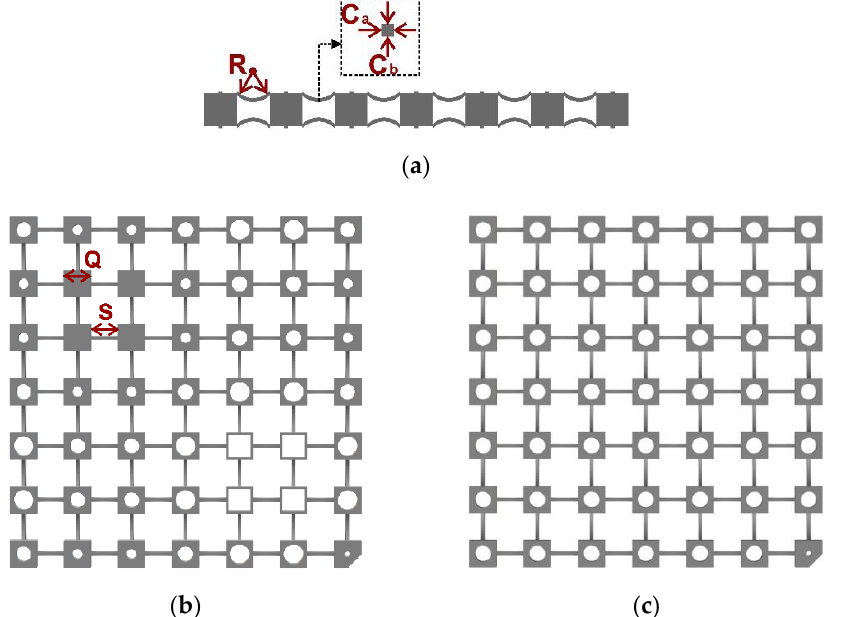
Figure 1. Schematic diagrams of the 2D rainbow and periodic metamaterials: ( a ) side view, ( b ) top view of the rainbow metamaterial, and ( c ) top view of the periodic metamaterial. The labels show the geometric parameters: block side length ( Q ), distance between blocks ( S ), curvature radius of the curved beam ( R ), and cross-section dimensions of the curved beams ( C a , C b ).